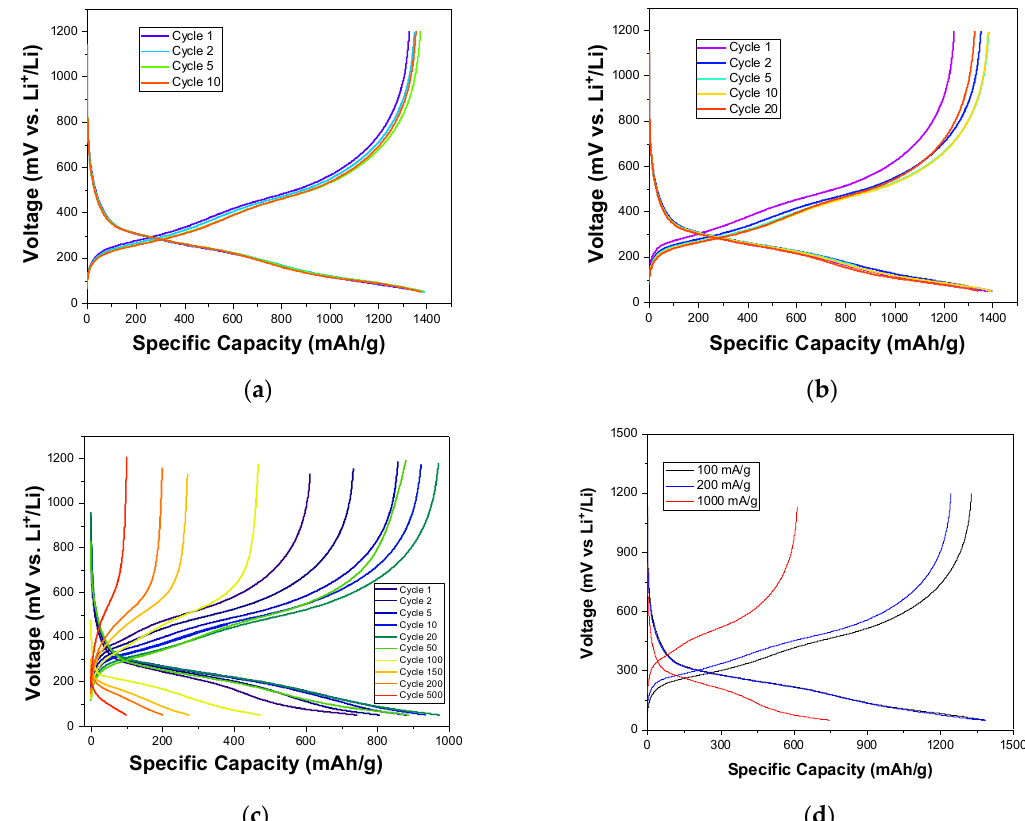
Figure 10. GCD profile of Si 3 N 4 @Si@Cu in a half cell at ( a ) 100 mA/g, ( b ) 200 mA/g, and ( c ) 1000 mA/g. ( d ) First GCD cycle of Si 3 N 4 @Si@Cu in a half cell at different current densities.